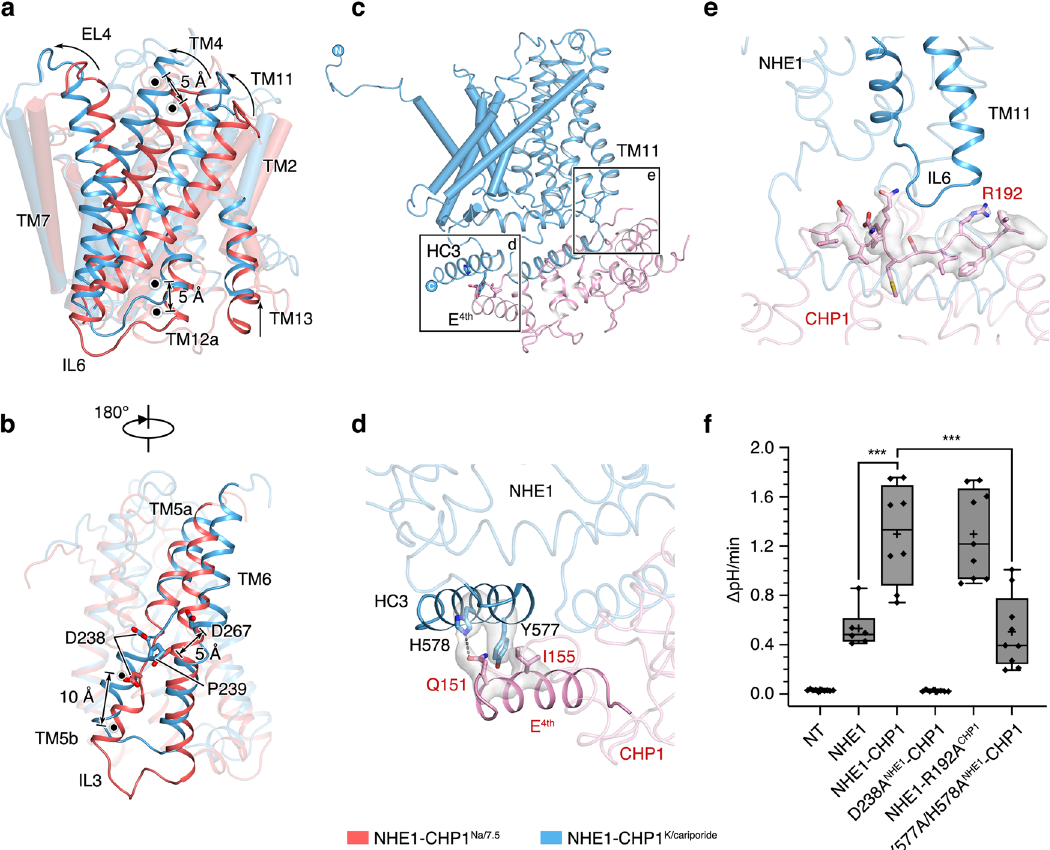
Fig. 5 Conformational change between the inward- and outward-facing NHE1. a , b Conformational change of the core domain relative to the dimerization domain, between the inward- (red) and outward-facing (blue) states. Dimerization domains are used for superimposition and shown in cylindrical helices. The COMs of residues of the core domain at extracellular side (V214, L224, A281, W411, L468, and M476) and intracellular side (L186, V245, E253, F439, P446, and V503) are depicted as black dots. Distances between COMs are indicated. Panel a and b differ by 180°. c – e Interaction between NHE1 and CHP1. The NHE1 and CHP1 molecules are colored in blue and pink, respectively. Sidechains are depicted as sticks and the cryo-EM density map is shown in surface models. f Measurement of NHE1 activity. AP-1 cells were transiently transfected with mCherry fl uorescent protein alone (NT, no transporter), wild- type NHE1 tagged at its C-terminus with mCherry alone, or wild-type or mutant NHE1 co-expressed with either wild-type CHP1 or mutant CHP1 (R192A CHP1 ), as indicated. The mCherry signal was used to identify transfected cells. The cells were acid-loaded by prepulsing with NH 4 + (as described in Methods section) and NHE1 activity was de fi ned as the initial linear rate of pH recovery ( Δ pH/min) upon addition of Na + to the bathing medium. Data are plotted as a box plot, with the box encompassing the interquartile range (25th − 75th percentile) including the mean (plus sign) and the median (straight line), and the whiskers showing the 99% con fi dence interval. Each symbol represents a single cell, and between 6 and 10 cells ( n value) were analyzed from two independent experiments (NT, n = 10; NHE1, n = 6; NHE1-CHP1, n = 8; D238A NHE1 -CHP1, n = 8; NHE1-R192A CHP1 , n = 9; Y577A/H578A NHE1 - CHP1, n = 9). Signi fi cance from WT was determined by one-way ANOVA (total degrees of freedom = 49; F value = 42.1, P value = 1.094 × 10 − 15 ), with